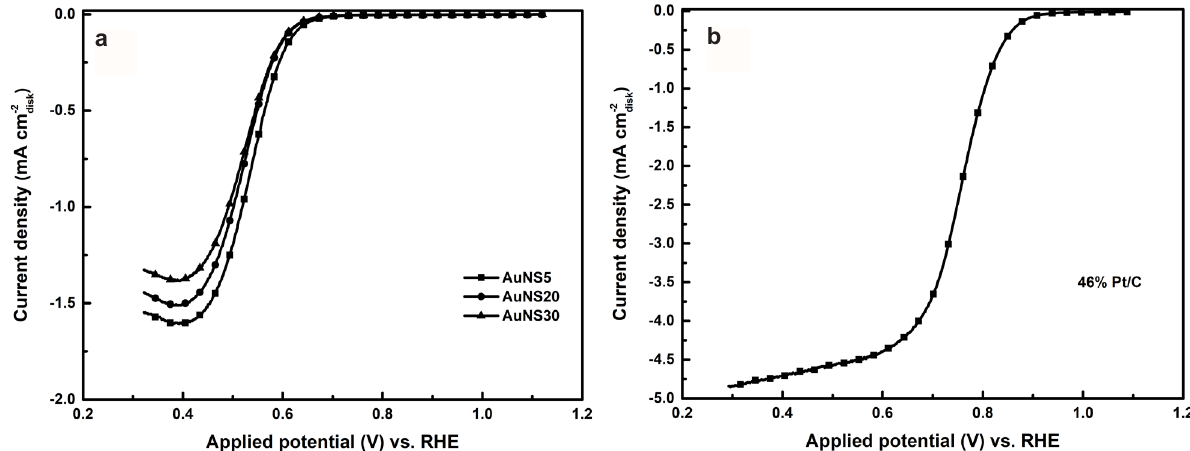
Fig. 3. A. The ORR activities of AuNS5, AuNS20, AuNS30, and B. the ORR activity of Pt/C catalysts in O -saturated 0.1 M KOH at 1600 2